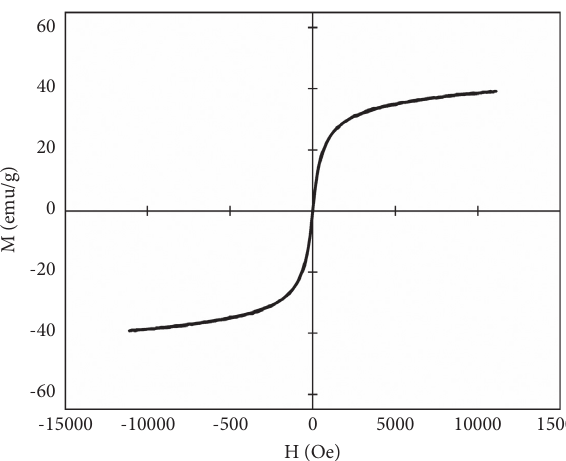
3 O 4 composite (a) and (b).